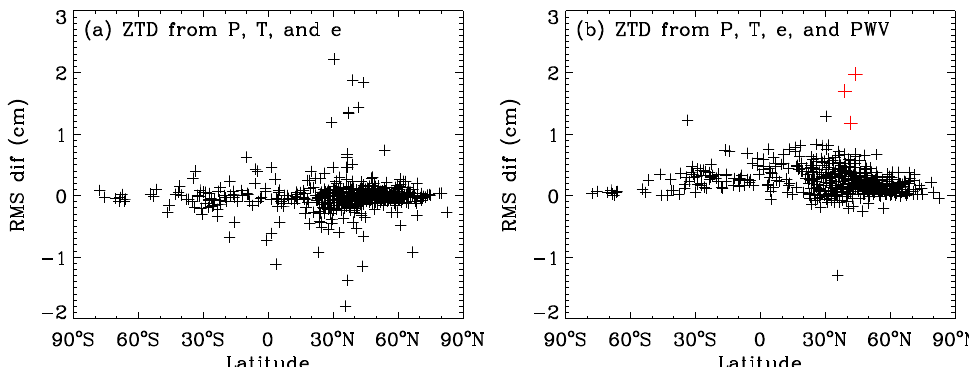
Figure 5. Station-specific differences in RMS values of ZTDs obtained from ERA surface data of two spatial resolutions. ( a ) refers to ZTDs derived from P , T , and e . ( b ) refers to ZTDs derived from P , T , e , and PWV. The symbol denotes the results obtained from 2.5° × 2.5° grid data minus those from 0.75° × 0.75° grid data.